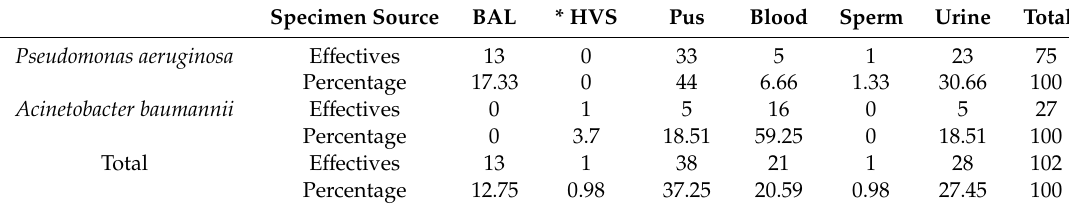
Table 2. Frequency of isolates according to specimen origin.